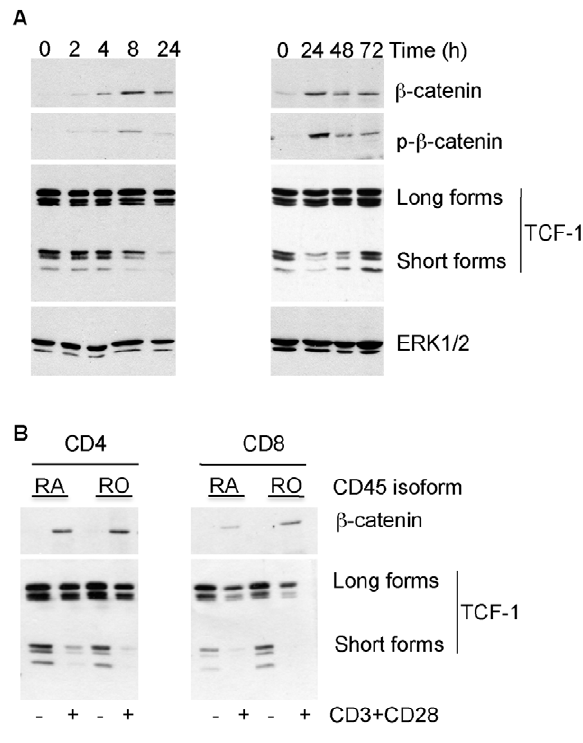
Figure 3. Induction of b -catenin correlates with a modulation of TCF1 isoform usage. (A) T cells were stimulated with plate bound anti-CD3 and anti-CD28 antibodies for the indicated times and immediately frozen as dry pellets on dry ice. Total cell lysates were prepared and run on SDS-PAGE, immunblotted for b -catenin, phospho- b -catenin and TCF-1. Total ERK expression served as a loading control. (B) T cells were fractionated based on the expression of CD4 and CD8 as well as CD45 isoform expression (CD45RA: naı¨ve T cells or CD45RO: memory T cells) as outlined in materials and methods. The cells were either left unstimulated or were stimulated overnight with anti-CD3/ CD28 antibodies. Total cell lysates were immunoblotted for b -catenin and